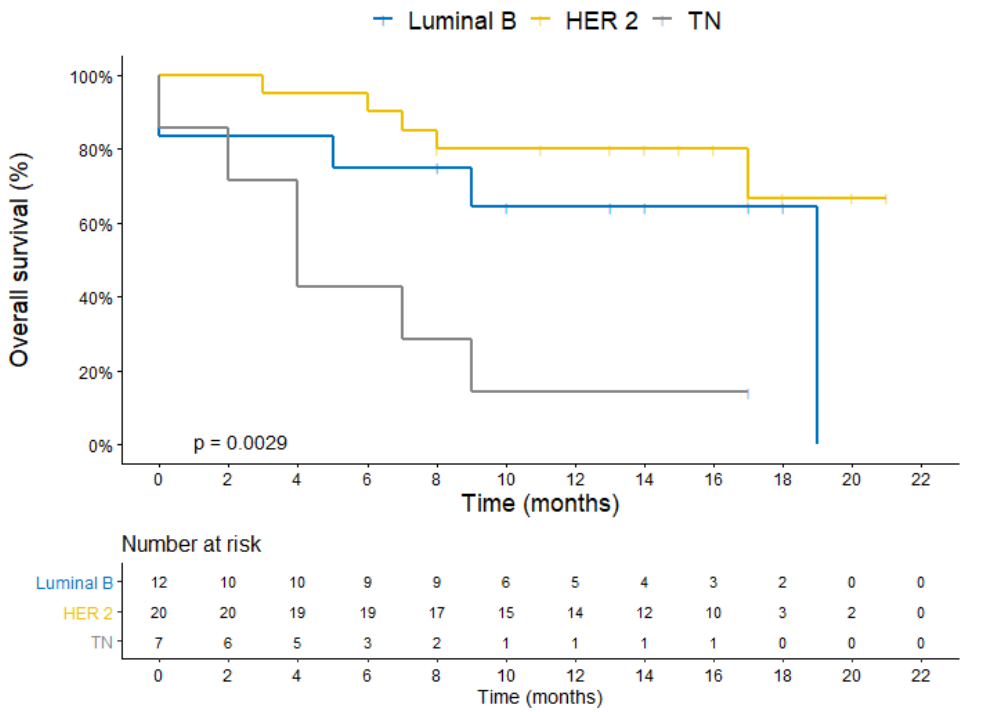
Figure 3. Kaplan – Meier plot for overall survival stratified by the primary immunophenotype. Figure 3. Kaplan–Meier plot for overall survival stratified by the primary immunophenotype. The median DBFFS was 10 months in 30 patients who were HER2-negative and not reached in 9 patients who were HER2-positive in the CTC ( p = 0.012) (Figure 4). The median OS was 17 months in patients who wereHER2-negative and not reached in patients who were HER2-positive in the CTC ( p = 0.104) (Figure 5).